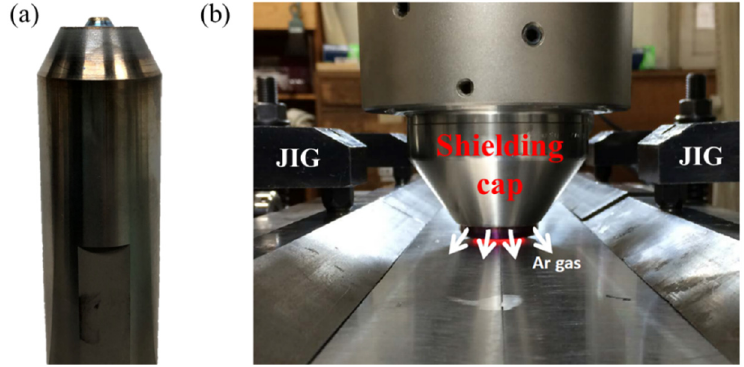
Figure 1. The photograph of ( a ) the tool used for friction stir welding in this experiment and ( b ) the pneumatic JIG and cap type local Ar shielding system.